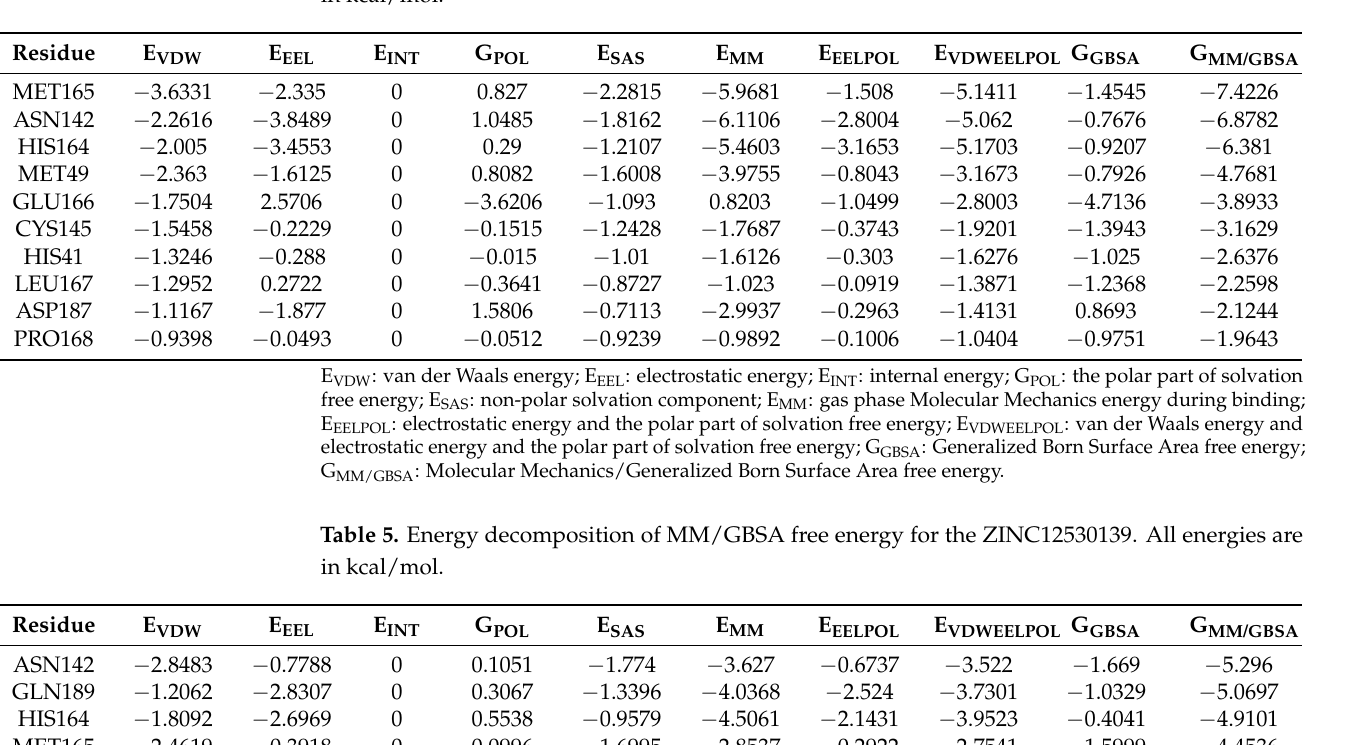
Table 4. Energy decomposition of MM/GBSA free energy for the ZINC09033700. All energies are in kcal/mol.